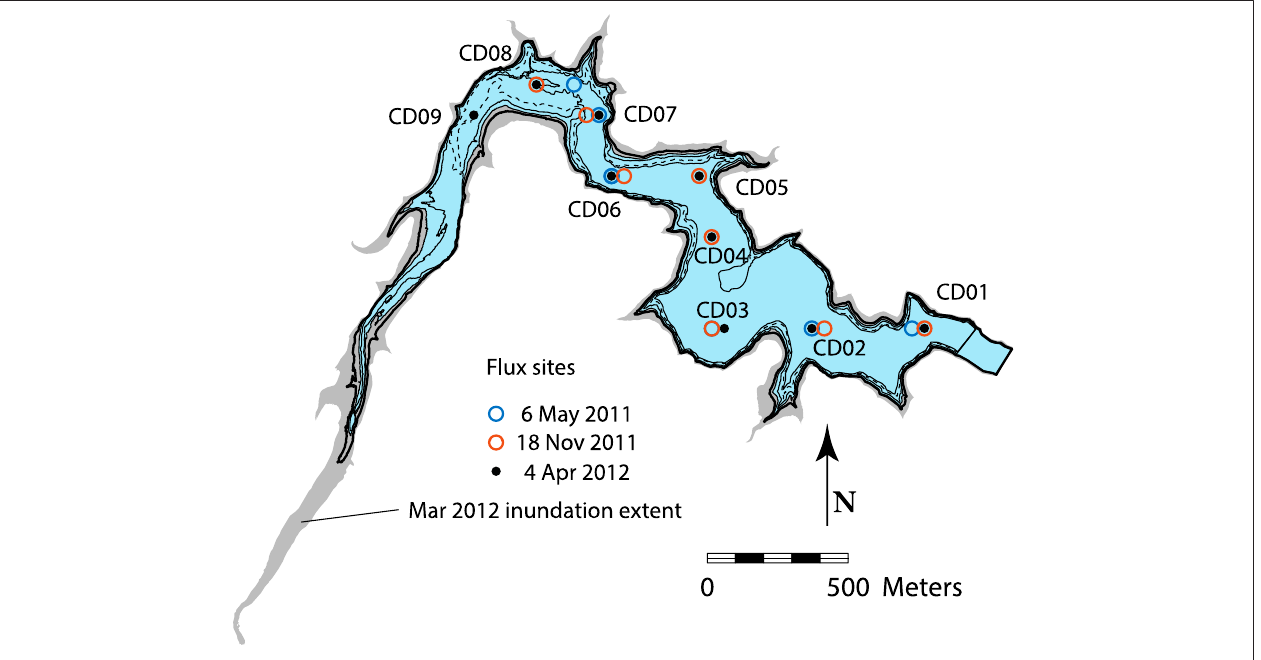
FIGURE2| Cotter damGHG fl uxmeasurement siteson6May2011,18November 2011,4April2012.Maximumextentsofinundationareshown asblueshaded area (504 m contour) for December 2010 and gray shaded area (512 m contour) for March 2012. Dashed line is 500 m; other contours are at 498, 502, 506 (bold) m.